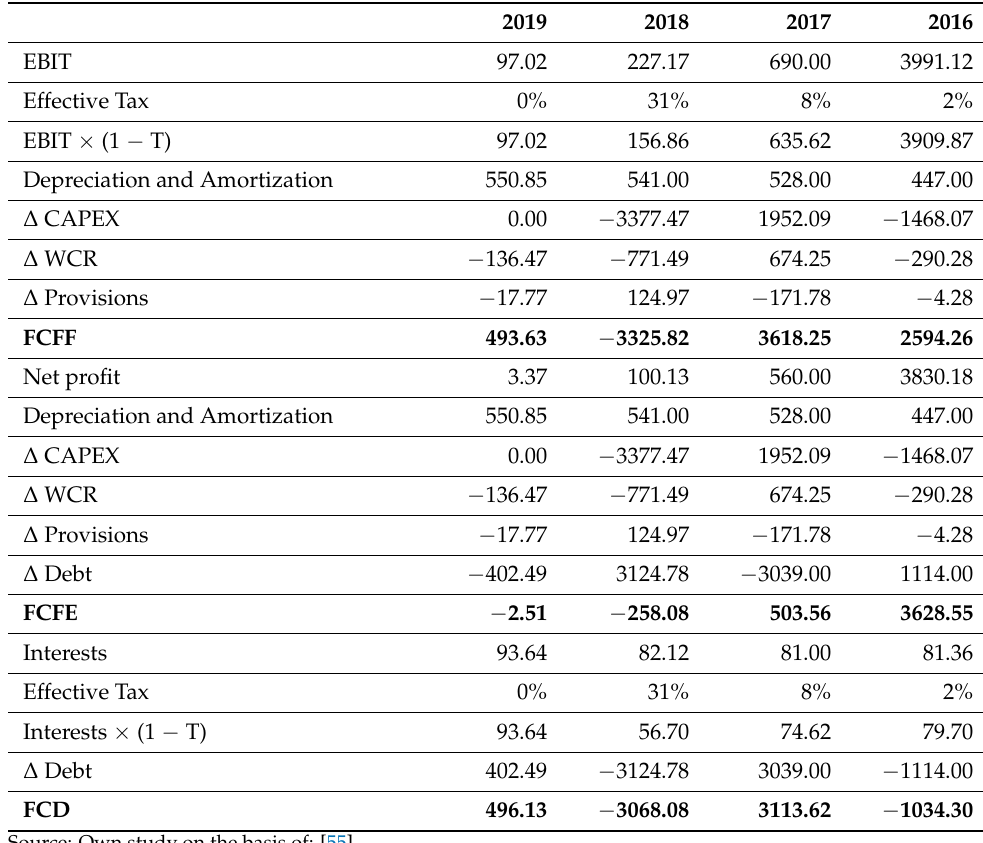
Table 12. Formation of FCFF, FCFE and FCD flows and the components affecting them in Geotermia Czarnk ó w Sp. z o.o. (PLN thousand).